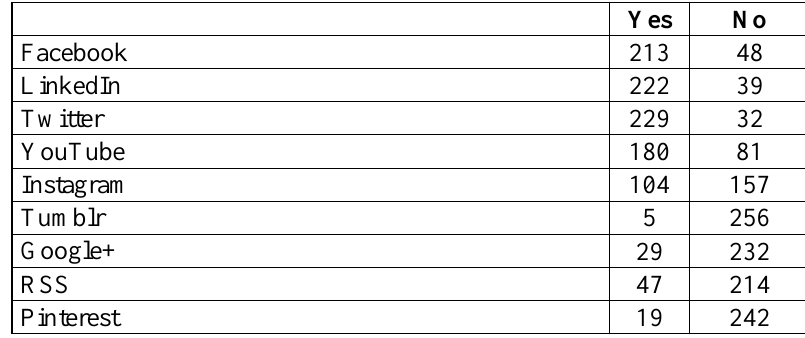
Table 5: Social Channels Used by DJSI Listed